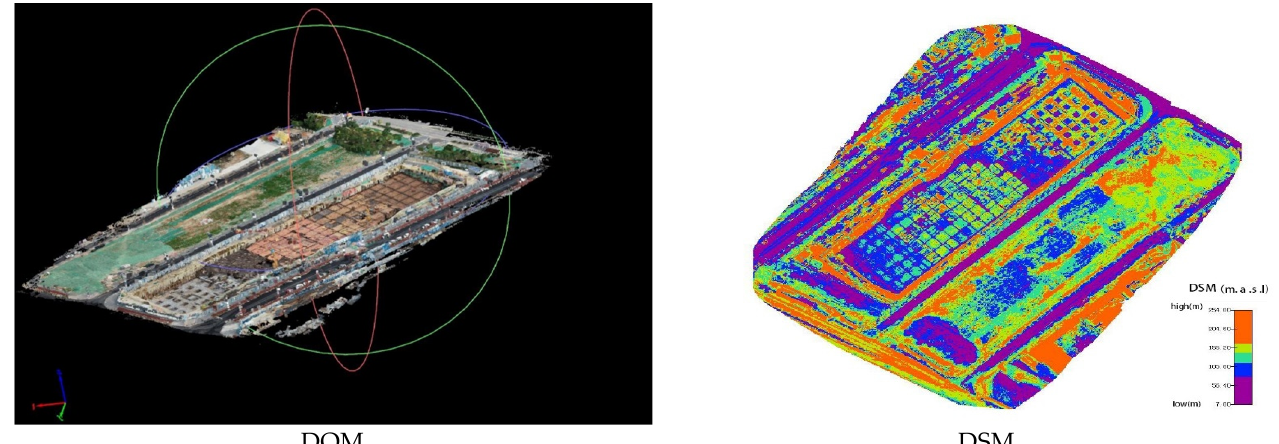
Figure 7. The image of the digital orthophoto map (DOM) and digital surface model (DSM).